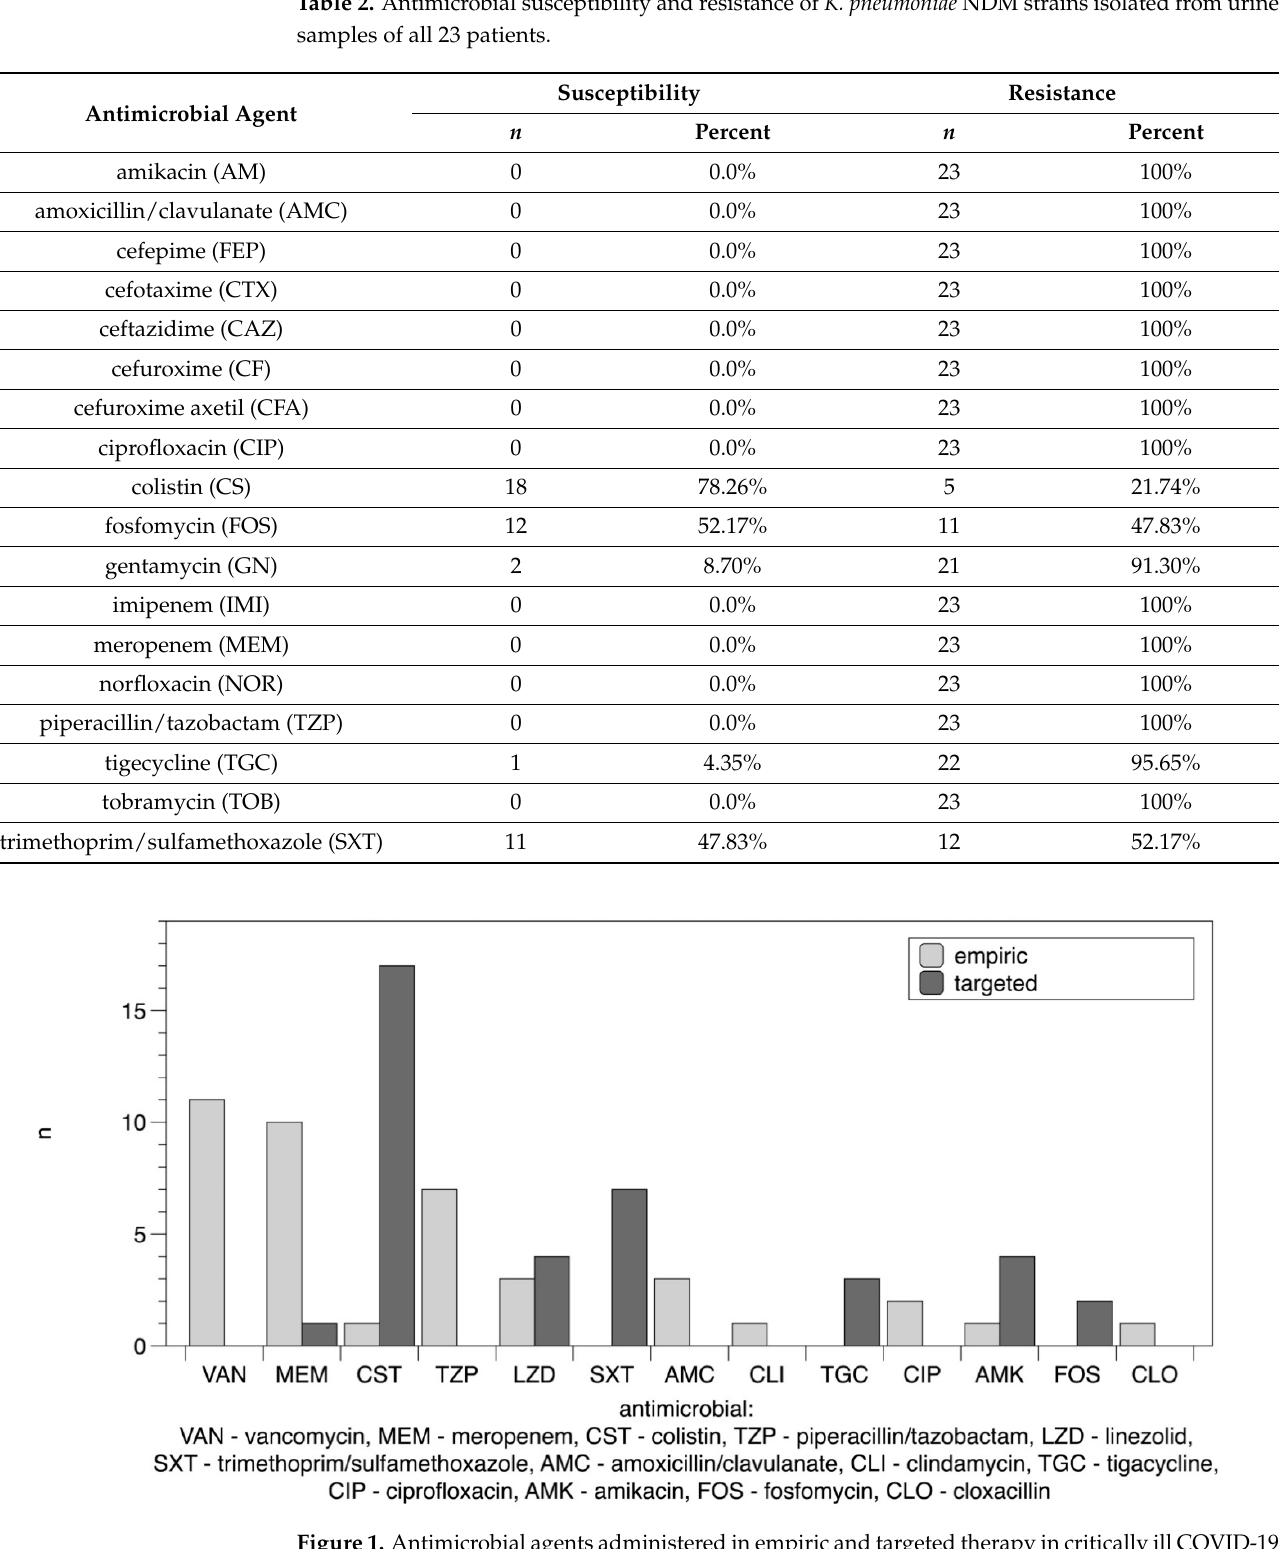
Figure 1. Antimicrobial agents administered in empiric and targeted therapy in critically ill COVID- 19 patients hospitalized in ICU infected with Klebsiella pneumoniae